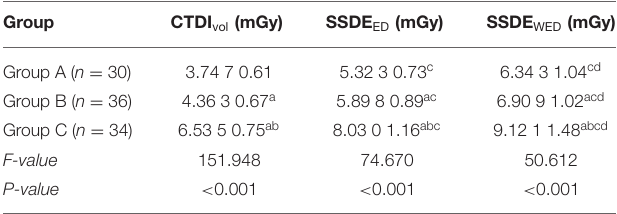
TABLE 2 | Comparison of CTDI vol , SSDE ED , and SSDE WED in patients with enhanced chest CT scan ( n , ±